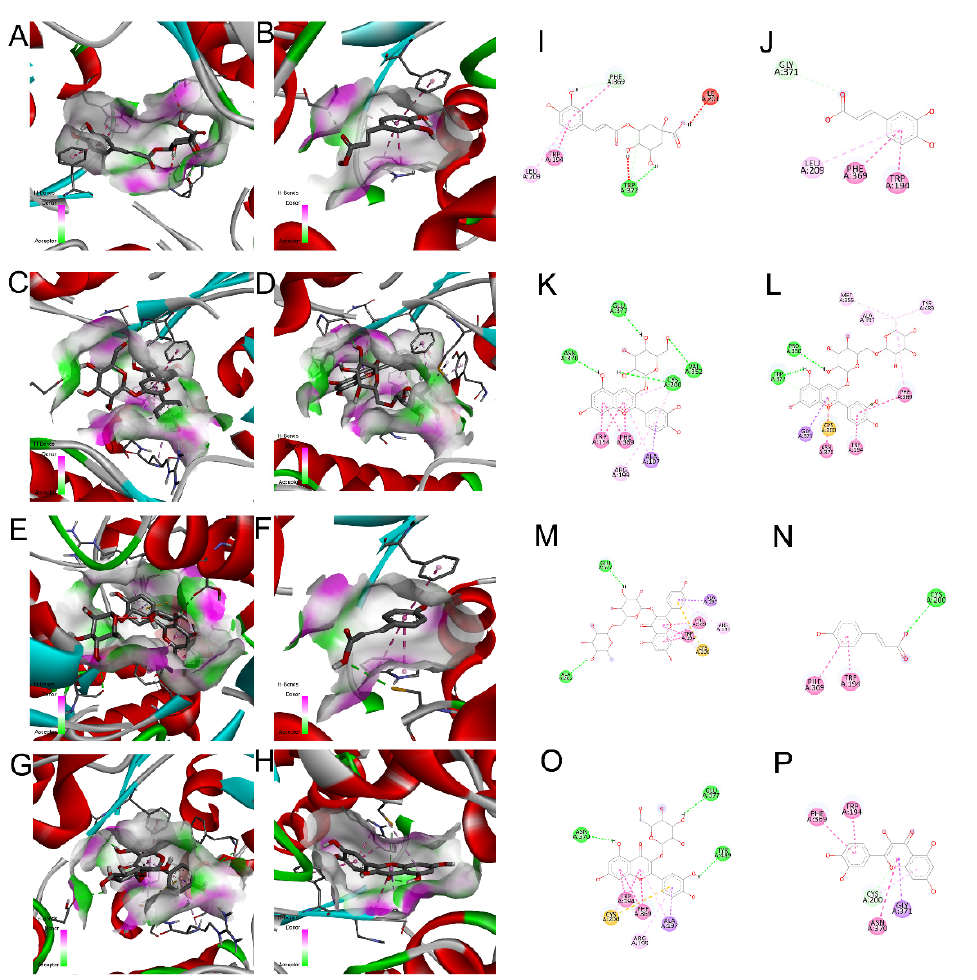
Figure 9. Energy interaction surfaced in a 3D model obtained by docking for each ligand-receptor interaction: ( A ), 3- O -caffeoylquinic acid; ( B ), caffeic acid; ( C ), cyanidin 3- O -glucoside; ( D ), cyanidin 3- O -rutinoside; ( E ), kaempferol 3- O -rutinoside; ( F ), p -coumaric acid; ( G ), quercetin 3- O -glucoside; ( H ), quercetin. 2D model diagram for efficient interaction of each ligand with the receptor: ( I ), 3-O-caffeoylquinic acid; ( J ), caffeic acid; ( K ), cyanidin 3- O -glucoside; ( L ), cyanidin 3- O -rutinoside; ( M ), kaempferol-3- O -rutinoside; ( N ), p -coumaric acid; ( O ), quercetin 3- O -glucoside; ( P ), quercetin.